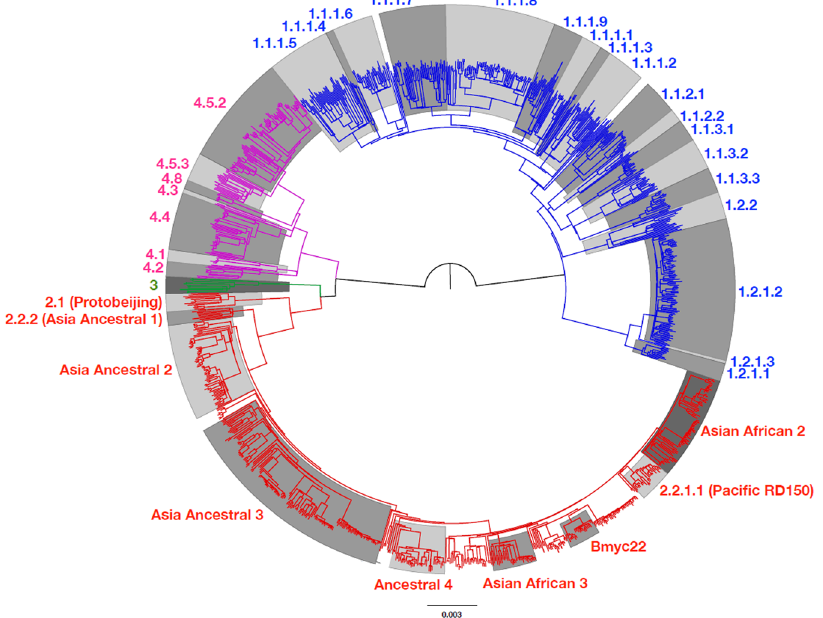
Figure 1. A phylogenetic tree of 1170 M . tuberculosis isolates from Chiangrai, constructed by using the Bayesian inference method. The shaded areas illustrate isolates belonging to the labelled sublineages. L1-4 are labelled with blue, red, green and purple lines, respectively. All L2 isolates, apart from 2.1 and L2.2.2 belong to L2.2.1. All isolates to the right of Ancestral 4 belonged to the Modern